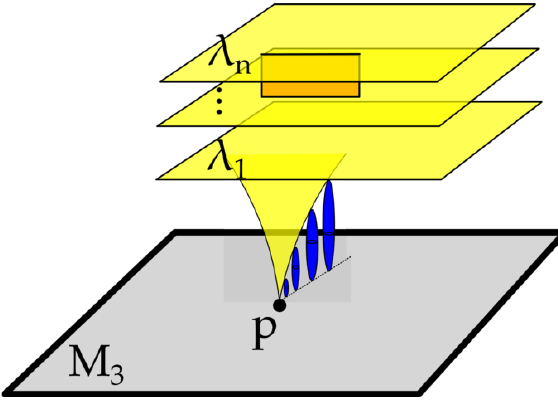
Figure 2 . Higgs bundle spectral cover over M 3 . Each sheet is labeled by an eigenvalue (cid:21) i of G ? . Each (cid:21) i is a one-form and their vanishing thus implies that they intersect the ‘zero section’, i.e. the locus of the ADE singularity of type G present in every ALE (cid:12)ber, over points p k on M 3 . Those points p i are precisely the loci where matter is localized. In the generic case of non-factored spectral covers, the sheets are furthermore connected by branch-cuts (orange). As we will see later on: in case the point p is connected by a (cid:13)ow line in M 3 to another critical point, there is a corresponding associative three-cycle which is built by (cid:12)bering the collapsing S 2 (blue) over the (cid:13)ow line. The resulting contribution to the superpotential gives a mass term for the localized